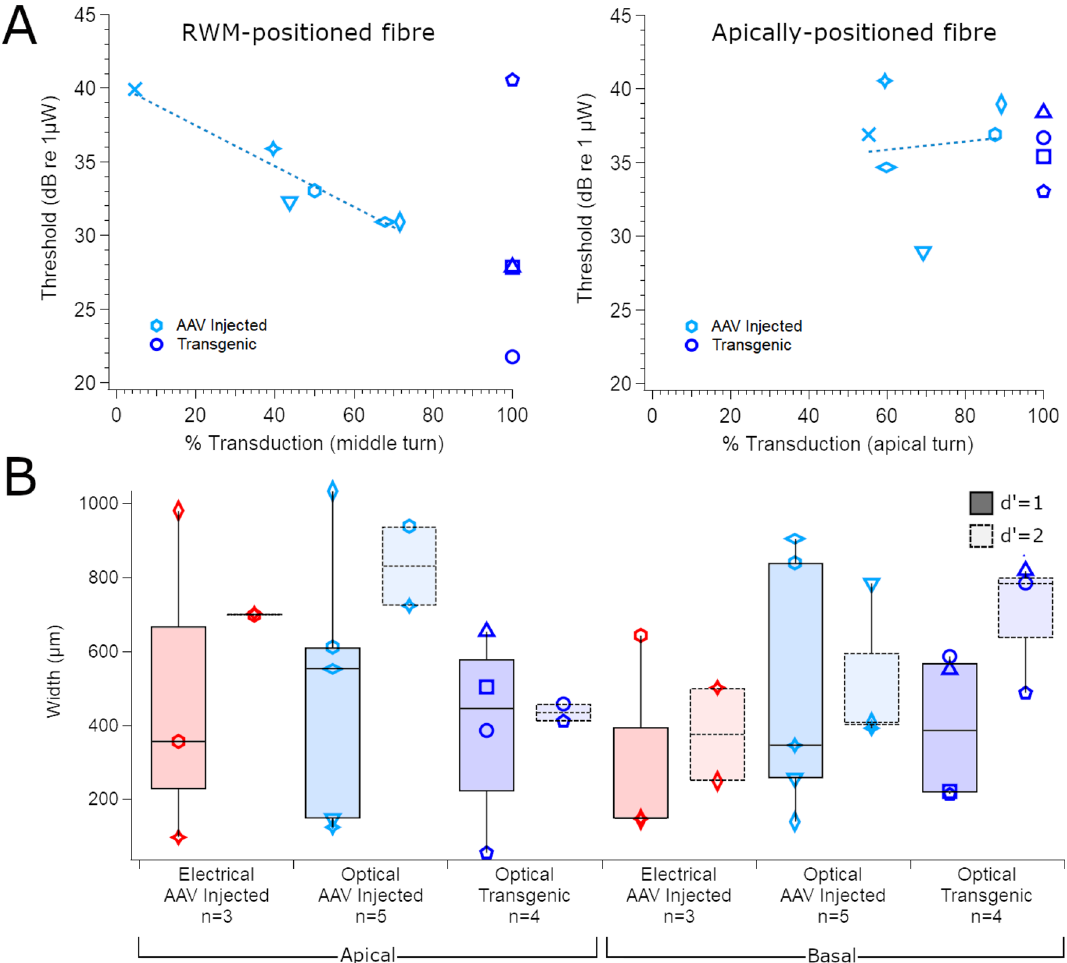
Figure 7. ( A ) Thresholds for optical activation via a RWM-positioned optical fibre or an apically-positioned optical fibre in C57BL/6 mice from the neonate AAV-injection group plotted against the percentage of neurons expressing ChR2-H134R-EYP in the middle turn (left; R 2 = 0.91, p = 0.003) or apical turn (right; R 2 = 0.19, p = 0.99) (n = 6). ChR2-H134R-EYFP transgenic mice with expression in all SGNs (100% of SGNs expressing ChR2-H134R-EYFP) are also shown for comparison (dark blue; n = 4). ( B ) Spatial tuning curve widths for electrical (red) or optical (blue) stimulation applied to the RWM or the apex of the cochlea. The width of the spatial tuning curve was measured at d’ = 1 above threshold or d’ = 2 above threshold where available. Spread of activation for transgenic mice are shown for comparison (darker blue). Box and whisker plots show median, first and third quartiles and the minima and maxima. Individual mice are symbol-coded. Basal turn data from ChR2-H134R-EYFP mice are a subset of the data presented in 35